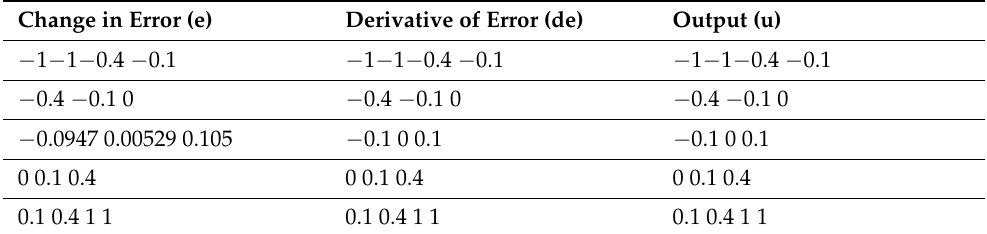
Table 3. Optimized fuzzy scaling factor